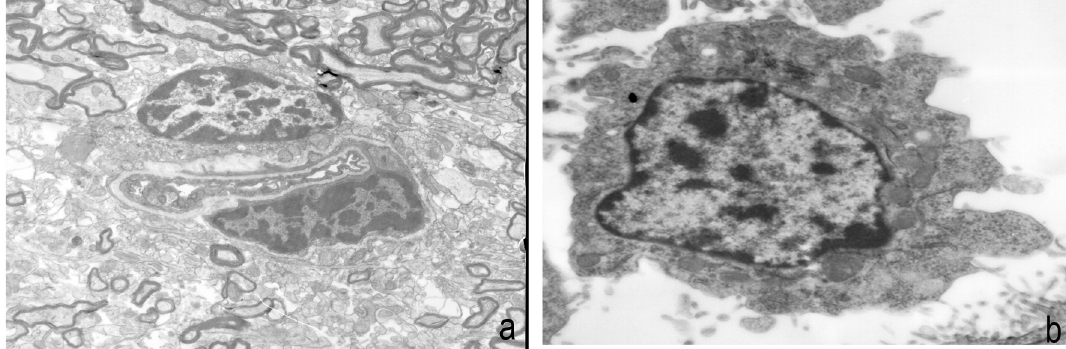
Figure 1 - Cell morphology and nucleus are irregular in the control group. a, multicells are shown in the micrographs; b, one cell is shown in the micrographs.